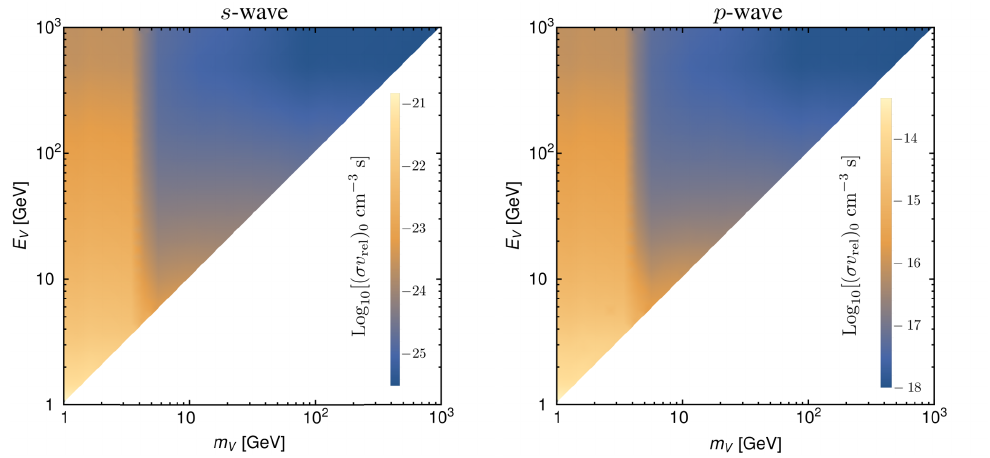
Figure 9: Limits from Fermi-LAT dSphs observations on the dark pho- ton production cross section, Eq. (33), with prefactor normalisation / ( f + f + [ 1 − f ] m ) 2 = 1 / ( 100 GeV ) 2 . Note the limit on the f 2 m m p e ion ion ion ion H ∼ 5 GeV due to the more efficient produc- flux becomes much stronger around m V tion of ordinary photons. The constraint on the velocity-independent part of the cross section is ∼ 8 orders of magnitude stronger when using the s -wave J -factors in ∼ 10 − 4 for dSphs. Note that comparison to the p -wave ones, as expected since v rel the constraints obtained using the s -wave J -factors can be applied on the averaged 〈 σ v 〉 , independently of the velocity dependence of the cross section, provided that rel the DM velocity dispersion is approximately constant within the regions of the halo that contribute significantly to the J